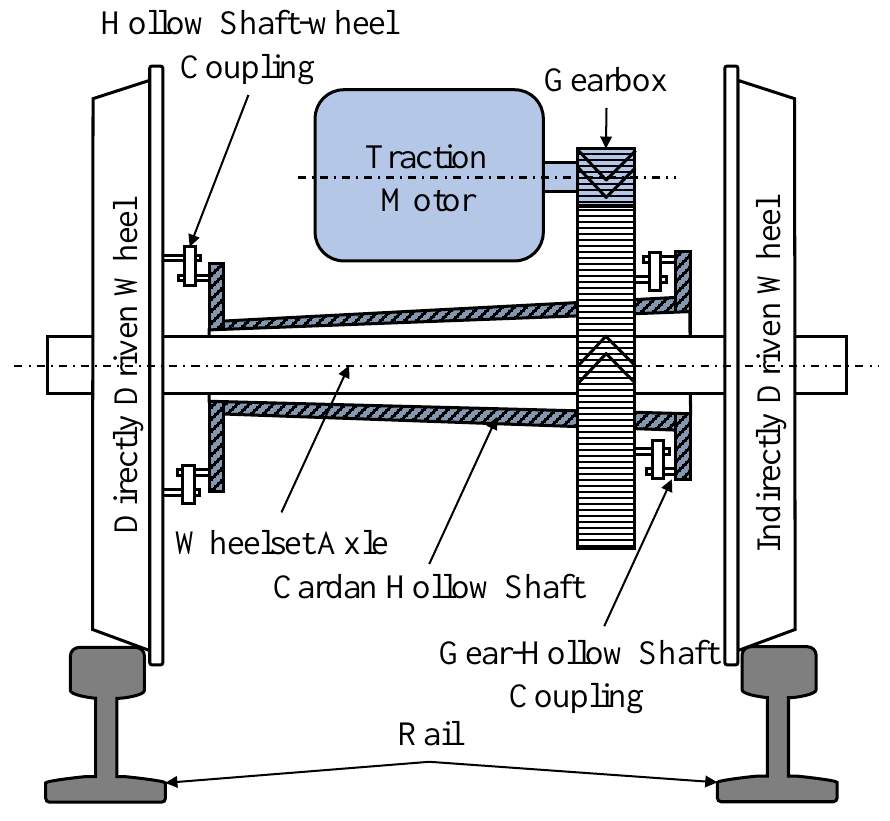
Figure 4. Structure of the mechanical model: mechanical elements of the traction drive train